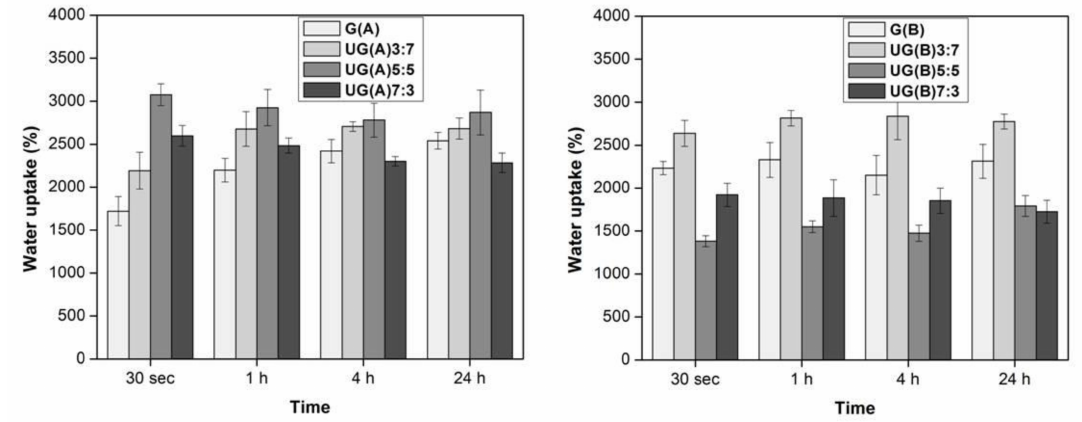
Figure 5. Water uptake ability (%) of UG sca ff olds as a function of time.